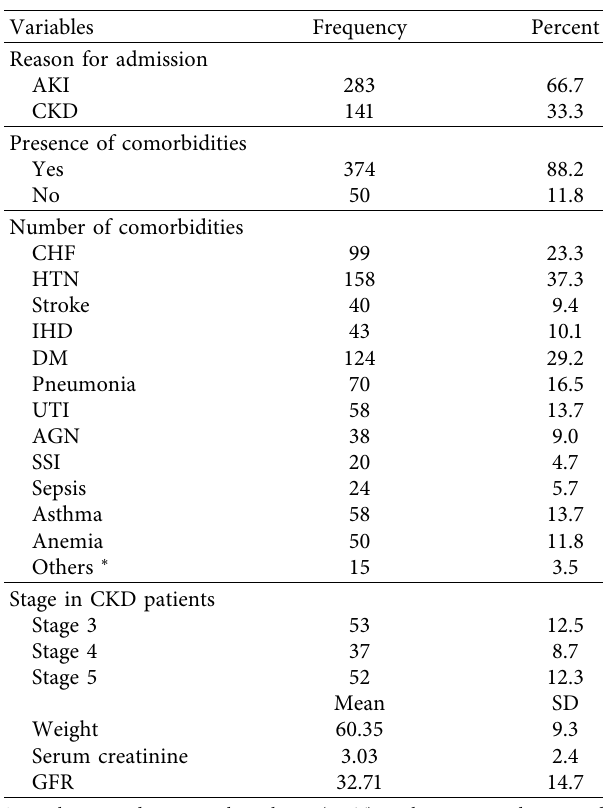
Table 2: Clinical characteristics of patients with renal